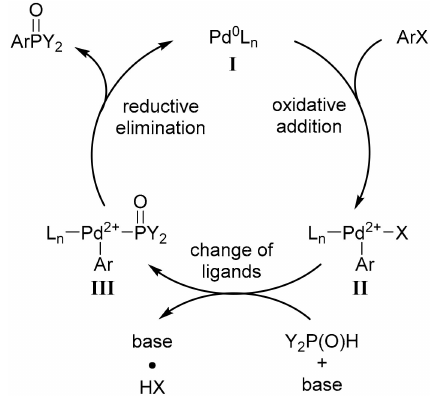
Figure 1. General scheme for the Pd-catalyzed Hirao